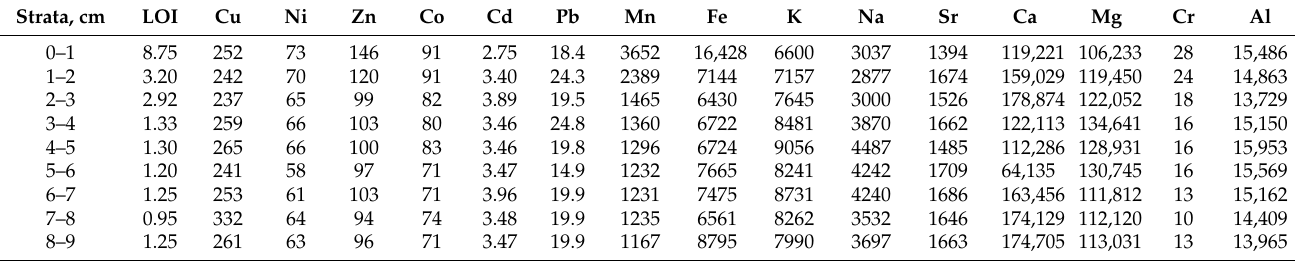
Table 7. Metal concentrations (mg/kg, dry weight) and weight loss on ignition (%) in the column of bottom sediments of the Kovdorsky GOK settling pond, upstream from the